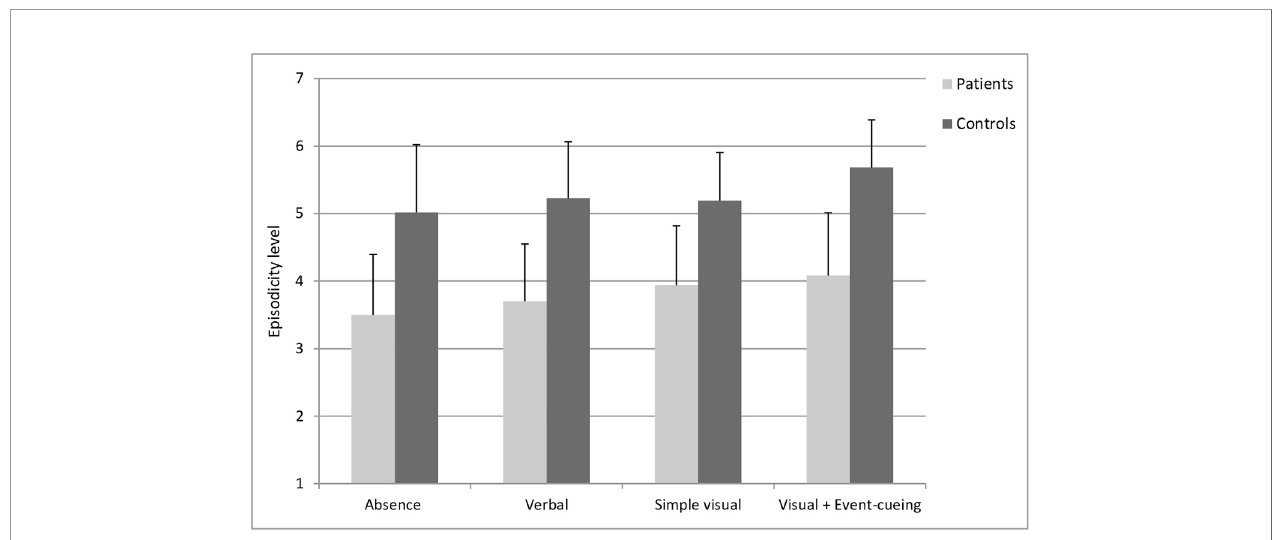
FIGURE 5 | Mean episodicity level (and standard deviations) evaluated by the participants during the recognition task. Episodicity levels were estimated as lower in the patient group compared to the control group. No other relevant differences were observed across the